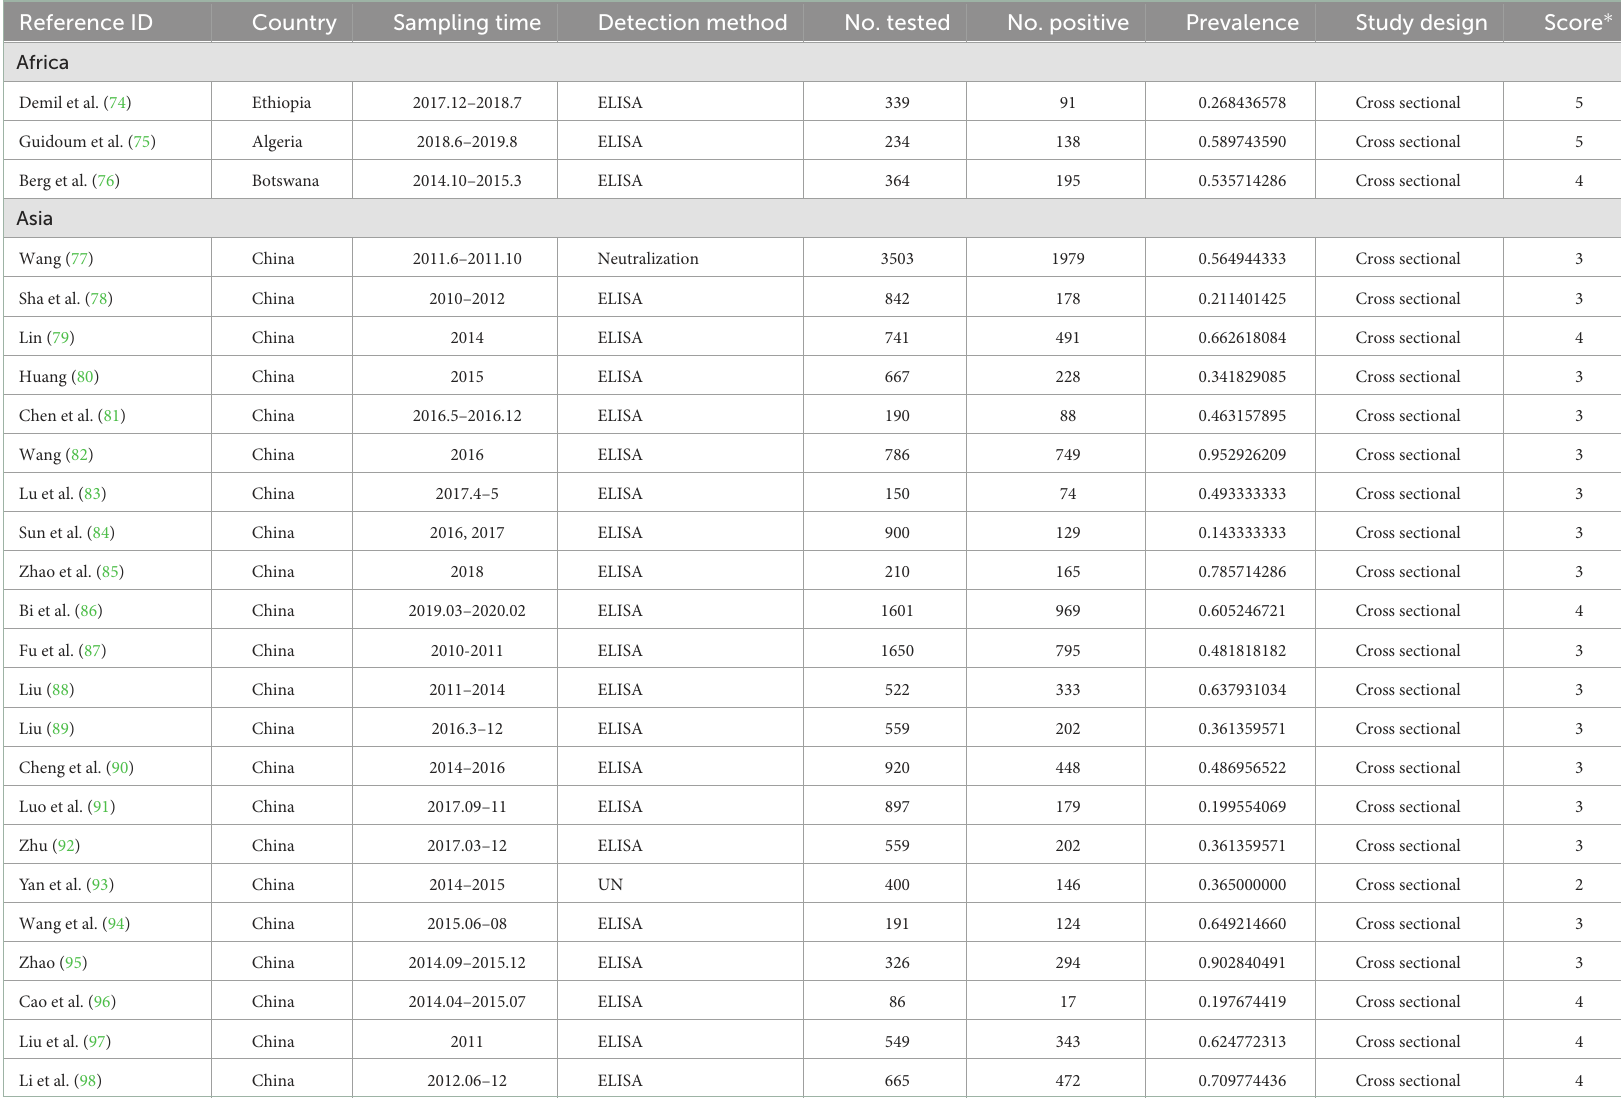
TABLE 3 Included studies of Bovine viral diarrhea virus infection of cattle in the